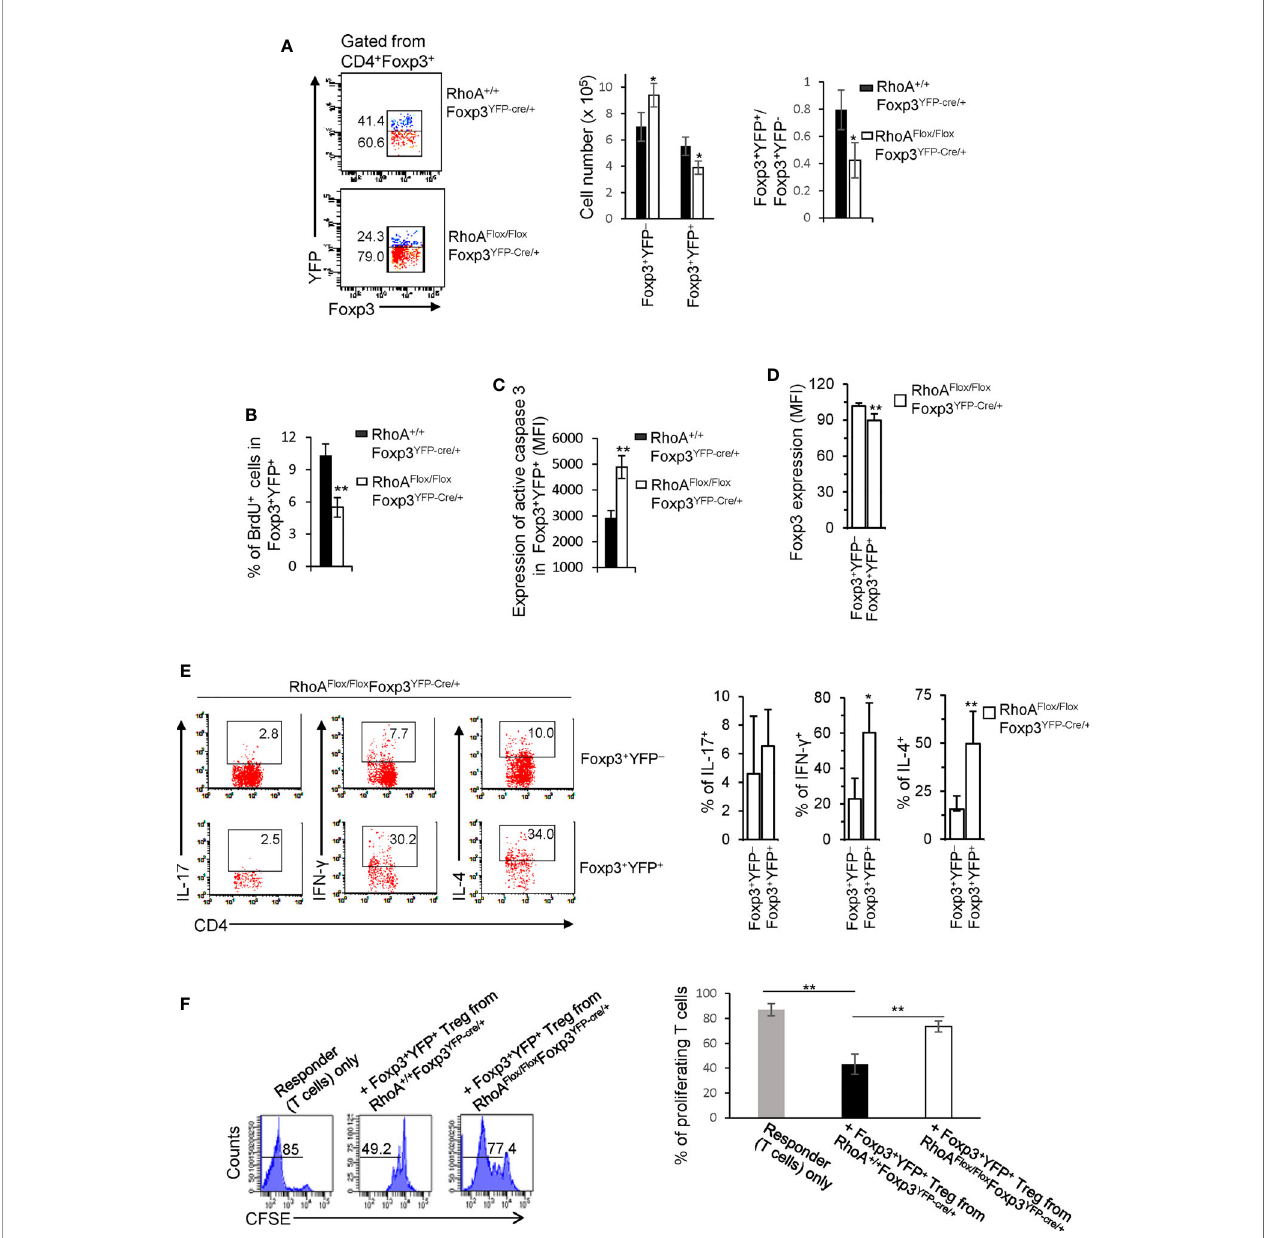
FIGURE 3 | Treg cells bearinghomozygous RhoA deletion are plasticand outcompetedby Treg cells bearingintact RhoA inRhoA Flox/Flox Foxp3 YFP-Cre/+ femalemice. (A) Left, representative fl ow cytogram of Foxp3 + YFP + and Foxp3 + YFP - cells inCD4 + Foxp3 + Treg cells from the spleen ofRhoA +/+ Foxp3 YFP-Cre/+ and RhoA Flox/Flox Foxp3 YFP-Cre/+ femalemice. The numbers indicate percentages of Foxp3 + YFP + and Foxp3 + YFP - cells. Middle, cellnumbers of Foxp3 + YFP + andFoxp3 + YFP - cells. Right, the ratio of percentages ofFoxp3 + YFP + versus percentages ofFoxp3 + YFP - cells. (B) Foxp3 + YFP + Treg cellproliferation. (C) Foxp3 + YFP + Treg cell apoptosis. (D) The expression levels (MFI: Mean fl uorescence intensity)ofFoxp3inFoxp3 + YFP + andFoxp3 + YFP - cellsfrom the spleen ofRhoA Flox/Flox Foxp3 YFP-Cre/+ femalemice. (E) Left, representative fl ow cytogram of IL-17, IFN- g , and IL-4 staining in CD4 + Foxp3 + YFP + and CD4 + Foxp3 + YFP - cells from the spleen of RhoA Flox/Flox Foxp3 YFP-Cre/+ female mice. The numbers indicate percentages of IL-17 + , IFN- g + , and IL-4 + cells. Right, average percentages of IL-17 + , IFN- g + , and IL-4 + cells. (F) In vitro Treg suppressive activity. Left, representative fl ow cytogram of CFSE dilution in T cells (responder). The numbers above the gating are percentages of cells low for CFSE, representing proliferating T cells. Right, average percentages of cells low for CFSE. Foxp3 + YFP + Treg cells were obtained by fl ow cytometry sorting of CD4 + YFP + cells from the spleen of RhoA +/+ Foxp3 YFP-Cre/+ and RhoA Flox/Flox Foxp3 YFP-Cre/+ female mice. Error bars indicate SD of 3 mice (A – E) or triplicates (F) . Data are representative of two independent experiments. *p < 0.05, **p <